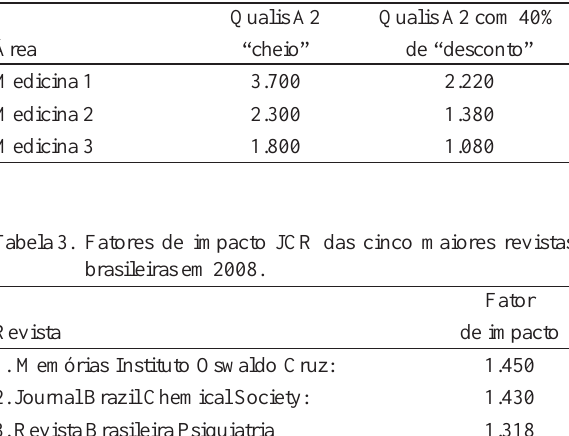
Tabela 2. Qualis A2 com 40% de desconto.